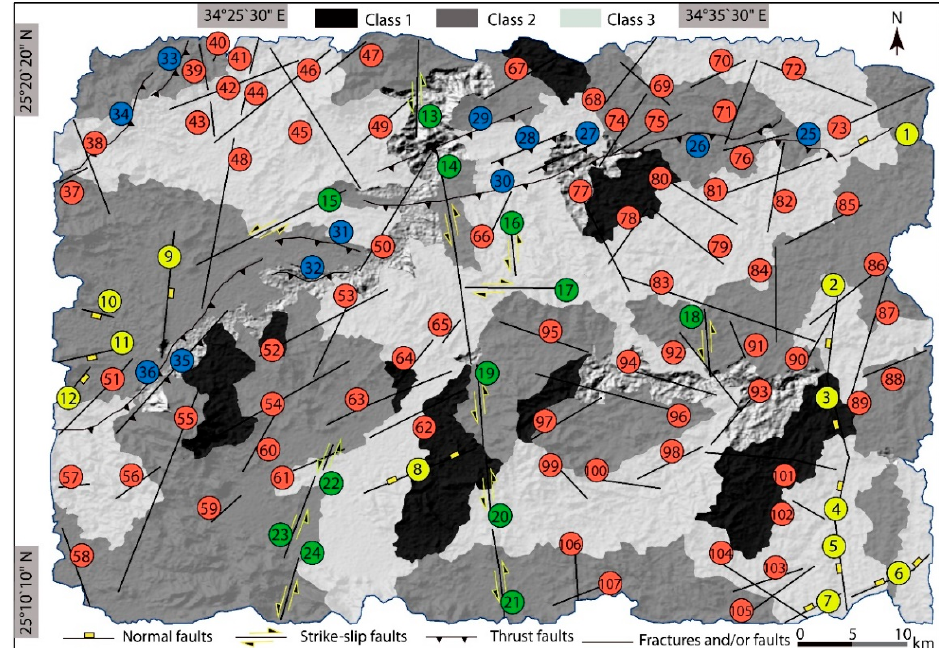
Figure 10. Map showing the distribution of the relative tectonic activity index (RTAI) of the study